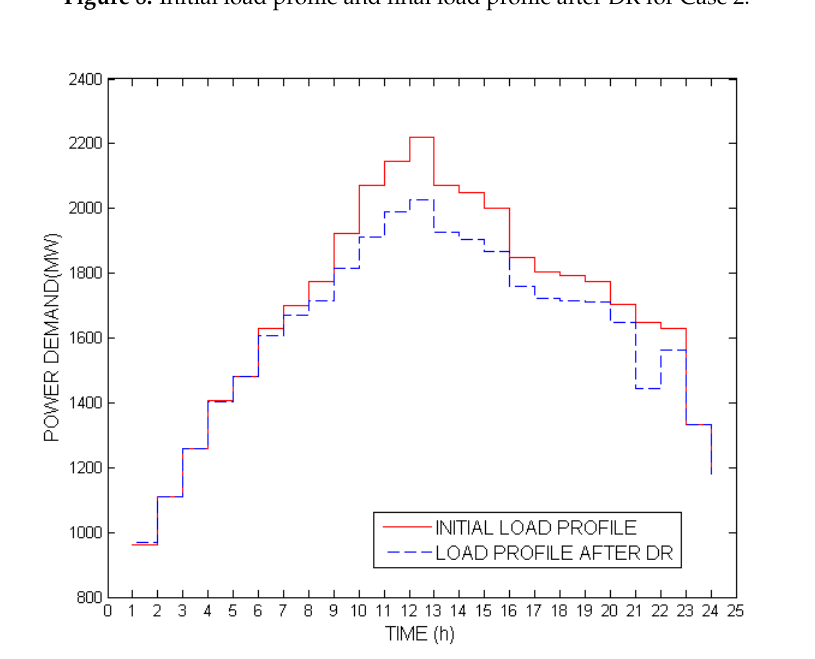
Figure 9. Initial load profile and final load profile after DR for Case